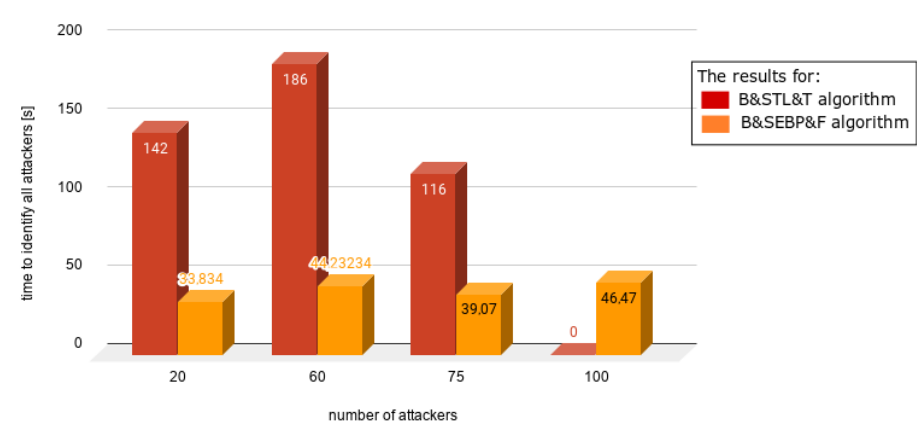
Figure 12. Results from experiments no. 8, 9, 10, and 11 (experiments can be found in Tables 3–7); according to Figure 11 the same number of users were involved—100; the number of attackers varied from 20 up to 100.